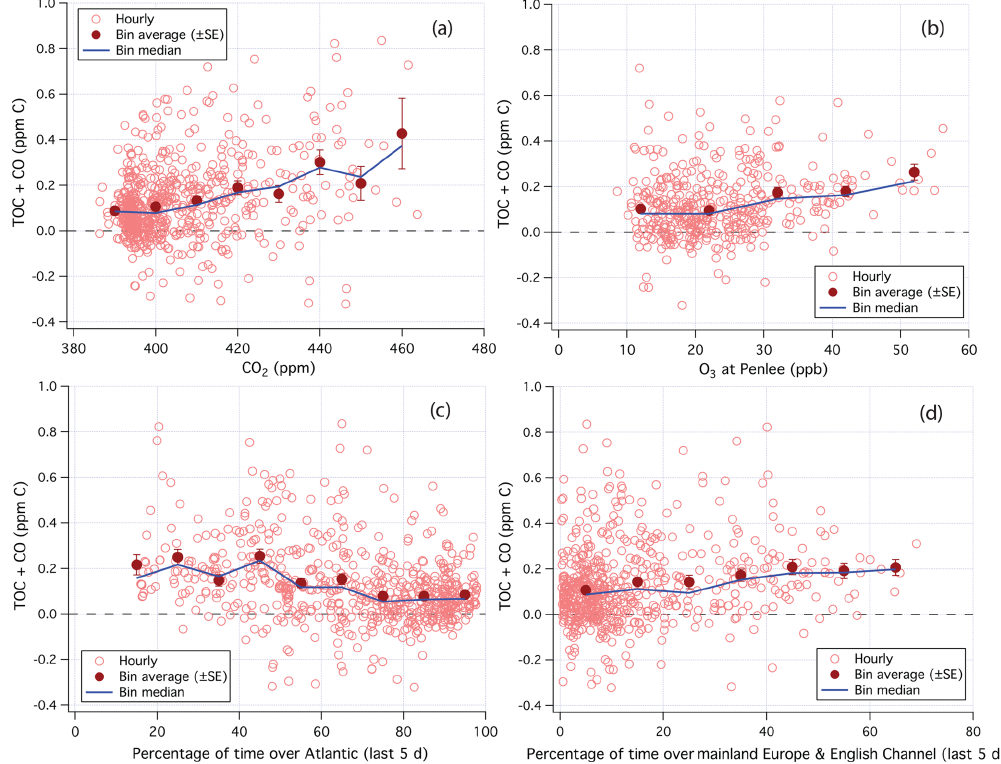
Figure 7. Relationship between TOC + CO and (a) CO 2 and (b) O 3 . (c) Percentage of time that the air mass was over the Atlantic Ocean over the last 5 days. (d) Percentage of time that the air mass was over mainland Europe and the English Channel over the last 5 days. Hourly data limited to weekends and weekday nights only.